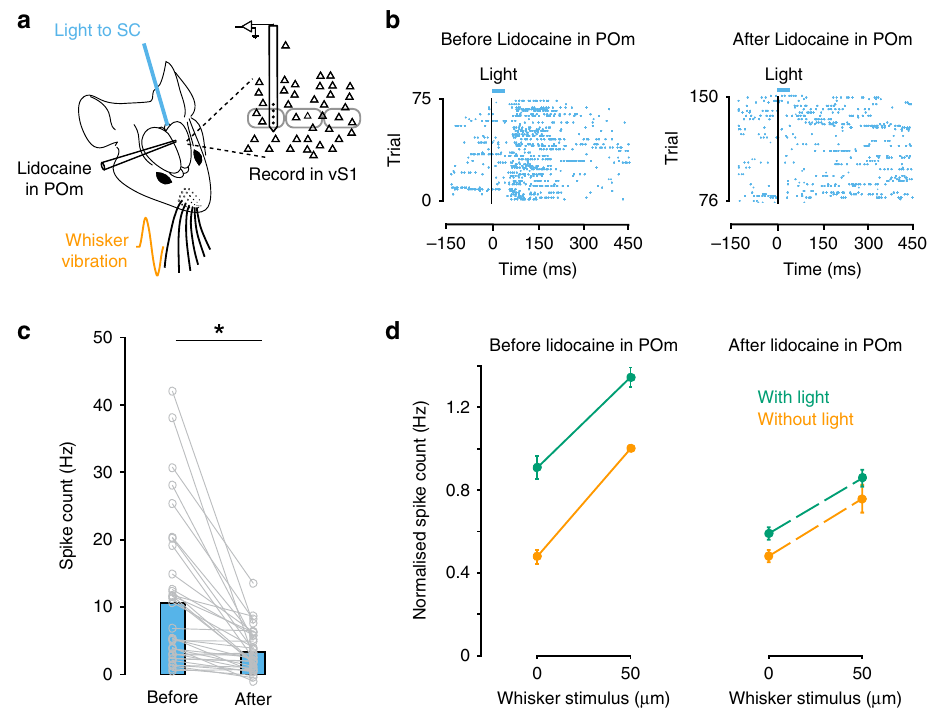
Fig. 7 Inactivation of POm abolishes the impact of SC on vS1 neurons. a Schematic of the experimental arrangement. After cutting the facial nerve, recordings were made from vS1 while activating SC optogenetically through an optic fi ber in the presence or absence of whisker vibration. POm was silenced by local application of lidocaine. b Raster plot during extracellular array recording of spiking in a vS1 neuron (787 µ m from the surface of the brain) in response to optogenetic activation of SC in control (left) and following inactivation of POm via lidocaine injection (right). c Plot of baseline-subtracted responses in a vS1 neurons to SC activation before and after lidocaine injection in POm ( n = 36). Asterisk represents p < 0.001 (Two-sided paired t -test). d Pooled data showing the impact of SC activation (green) on spiking in whisker responsive vS1 neurons during small amplitude whisker movement (orange) in control (left) and following inactivation of POm following lidocaine injection (right). Only neurons that were responsive to both whisker and SC stimulation were included in this analysis ( n = 23). The spiking activity of each neuron was normalized to the maximum response to whisker stimulation alone in control. Error bars represent SEM. Source data are provided as a Source Data fi